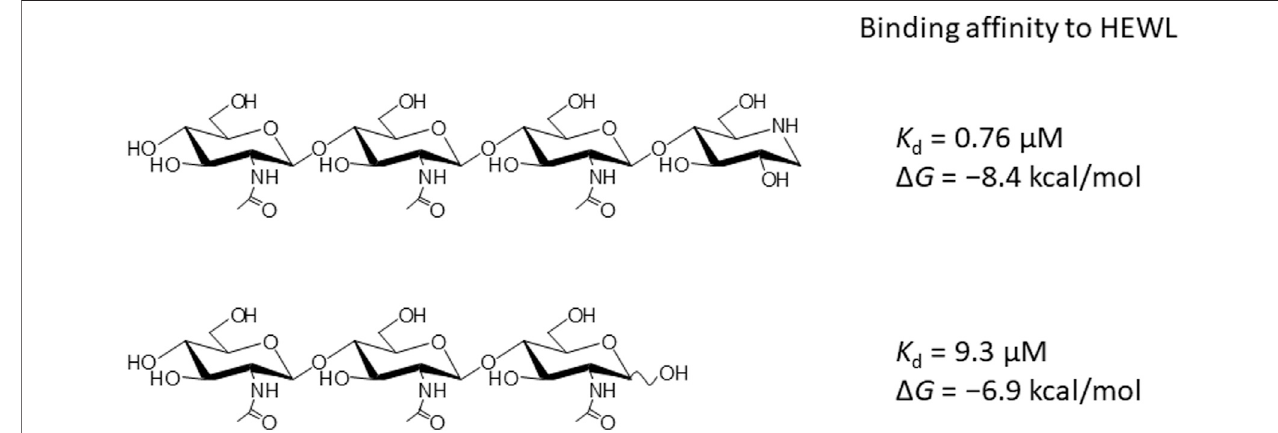
FIGURE 1 | Chemical structure of GN 3 M and (GlcNAc) 3